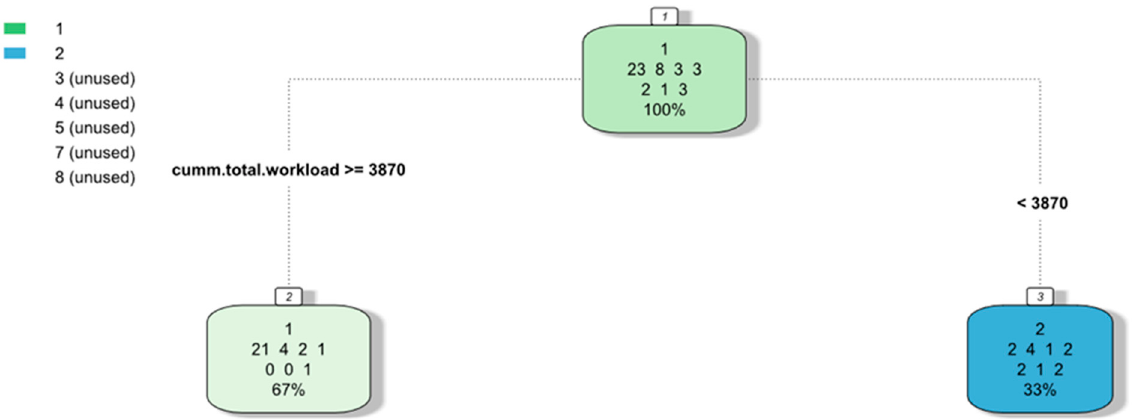
Figure 4. Business Process Intelligence Challenge (BPIC) 12—classification tree indicating factors driving degree of non ‐ linearity (edf).